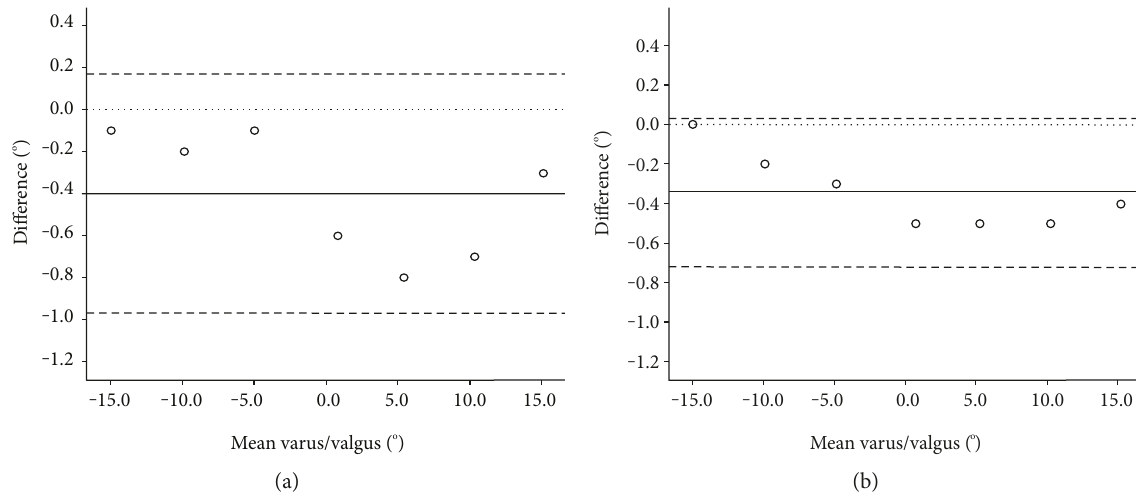
Figure 3: Inter- (a) and intraoperator (b) Bland-Altman plots of the di ff erence between the measured and actual varus/valgus angle ( ° ) plotted against the mean of the measured and actual angle. The mean (solid line), zero (dotted line), and limits of agreement at ± 1.96 SD (dashed lines) are shown. Table 1: Individual and overall results for the three operators across n subjects (2 n limbs) for all 6 variables in standing and supine positions.